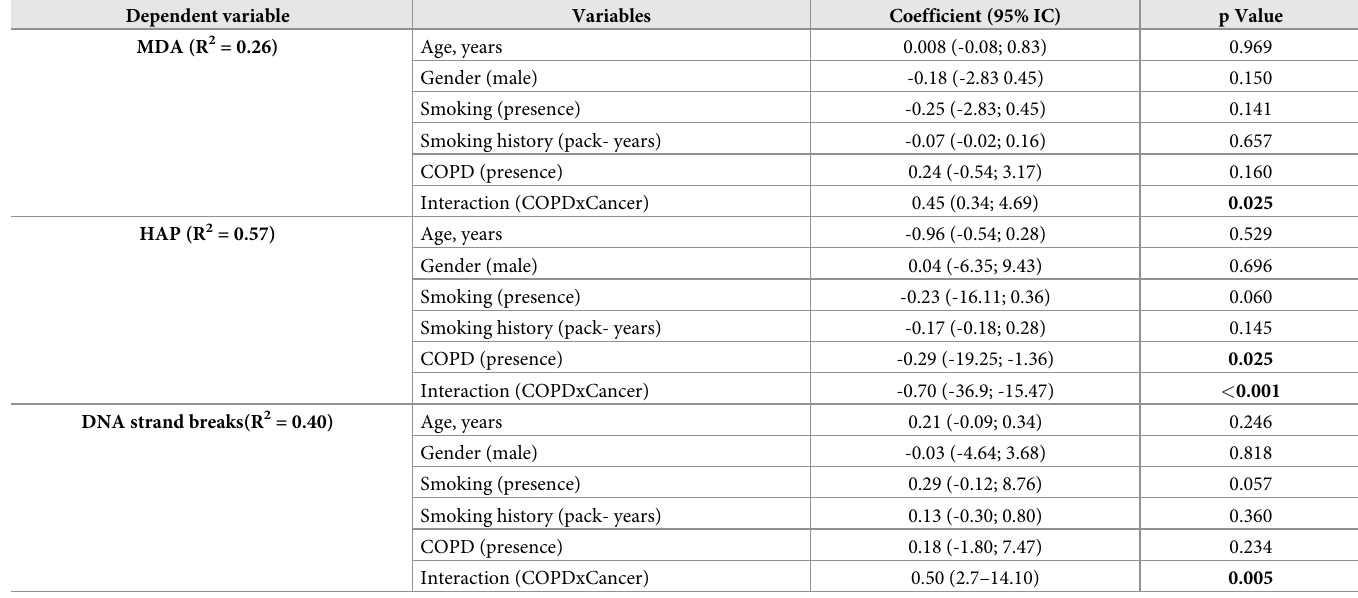
DNA strand breaks(R 2 =